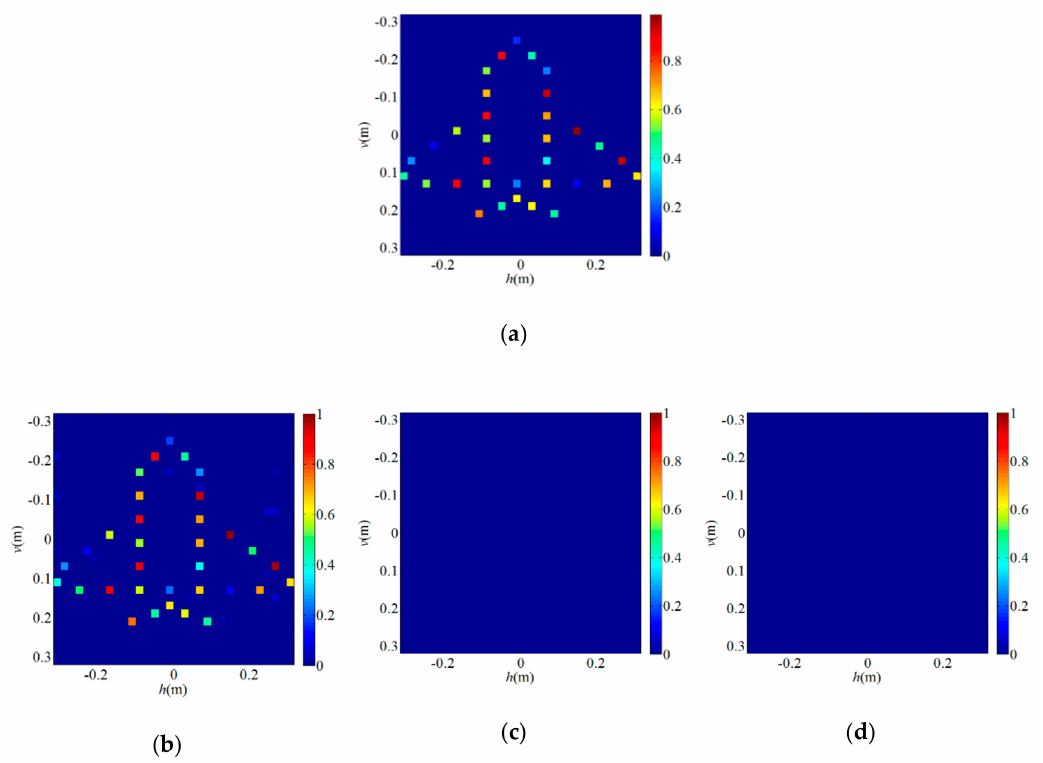
Figure 4. Imaging results for the sparse target when L / W = 1.5 in the PL-TCAI system with the setting SNR = 20dB: ( a ) original sparse target; ( b ) SWFOS algorithm; ( c ) SWF algorithm; and ( d ) SPARTA algorithm.